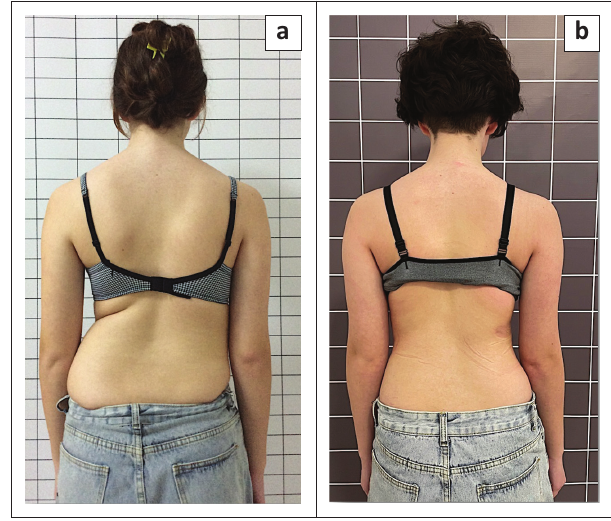
FIGURE 7: (a) Patient with a significant curve, (b) with a full clinical correction after treatment with a high impact Chêneau-style